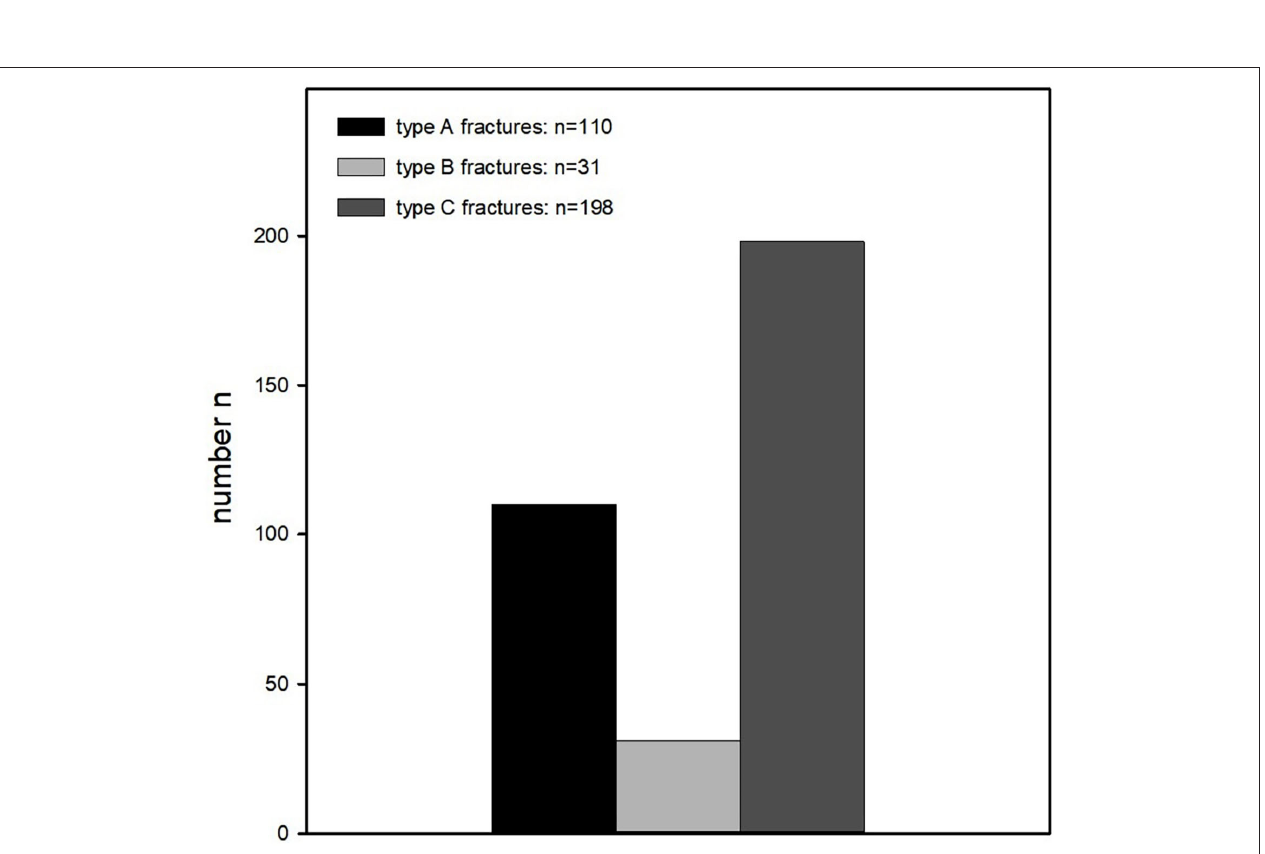
Frontiers in Surgery |